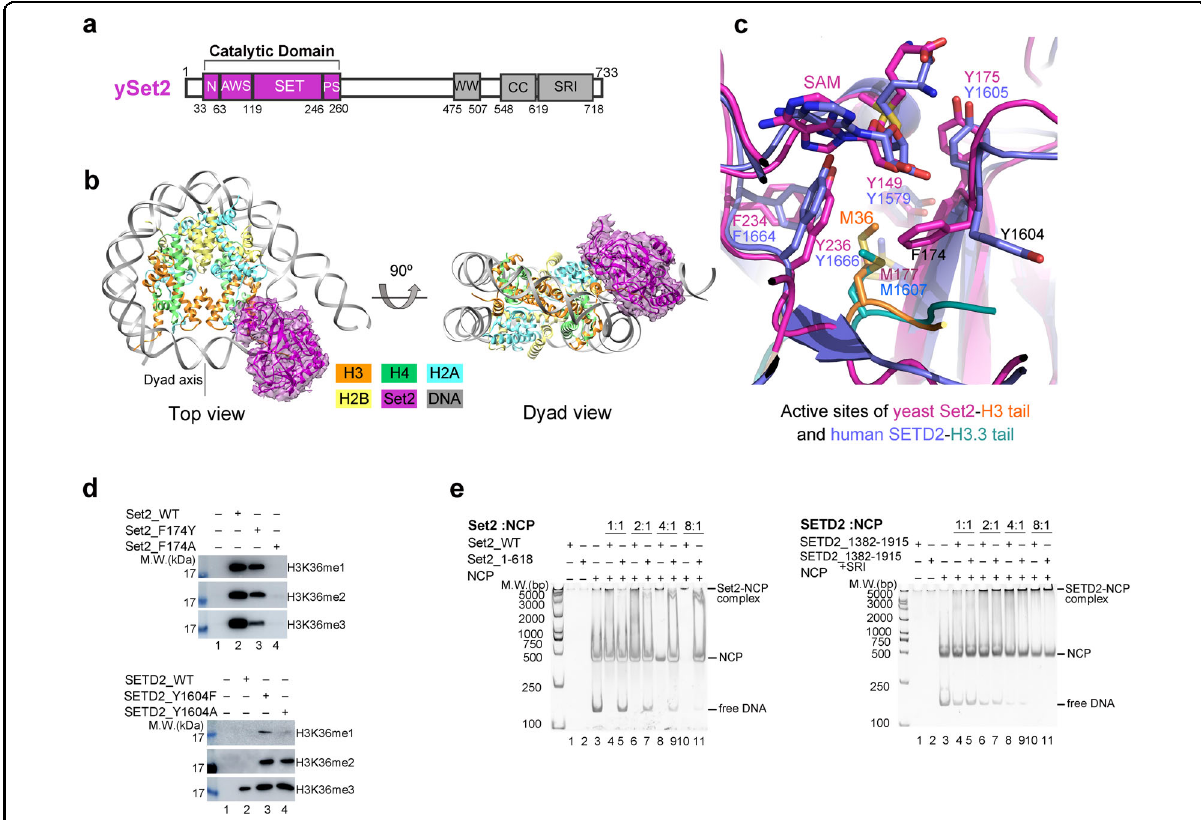
Fig. 4 Structural and biochemical comparison between human SETD2 – hNCP H3.3K36M and yeast Set2 – xNCP H3K36M complexes. a Schematic drawing of the domain organizations of yeast Set2. The color scheme is the same as that of the Set2 – xNCP H3K36M structural model. b Cryo-EM density map and atomic model of yeast Set2 – xNCP H3K36M complex shown from two orthogonal views. The cryo-EM map was segmented and colored according to the respective components of the Set2 – xNCP H3K36M complex. c The detailed view of the active site in yeast Set2 and human SETD2. d HMT assays of wild-type and mutant Set2 (top) and SETD2 (bottom) proteins against nucleosome substrates. Mono-, di-, and tri-methylation levels of histone H3K36 are determined with antibodies of H3K36me1, H3K36me2, and H3K36me3. The input of the reactions is shown in Supplementary Fig. S10d. Each assay was repeated at least three times with similar results. e EMSAs of different truncations of Set2 (left) and SETD2 (right) with nucleosome at molar ratios of 1:1, 2:1, 4:1, and 8:1. The Native-PAGE gel is stained with ethidium bromide (EB) to show the gel shifting of NCP by Set2/SETD2. The input of the assays is shown in Supplementary Fig.